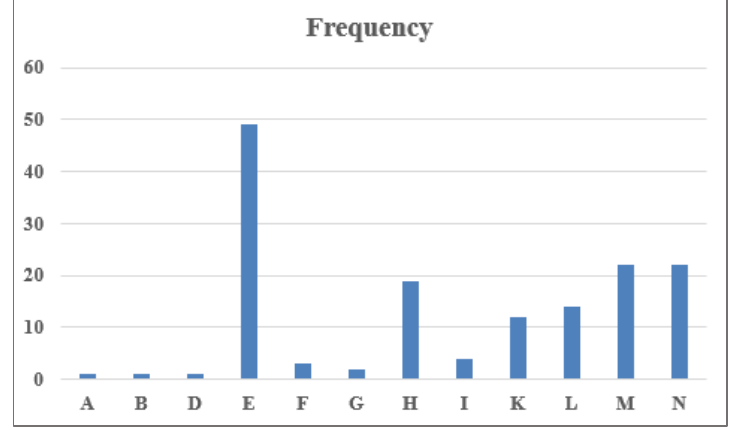
Figure 13. Frequency of the key change temporal on 7 July 2020.